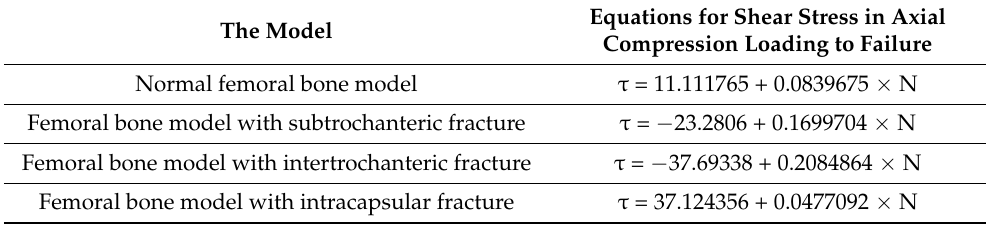
Table 6. Equations for shear stress in axial compression loading to failure.